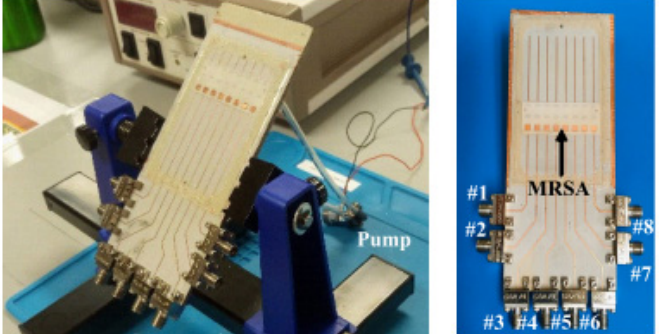
Figure 21. Fabricated model of the MRSA [58]. Table 4. Comparison analysis of fluidic based spst switches.